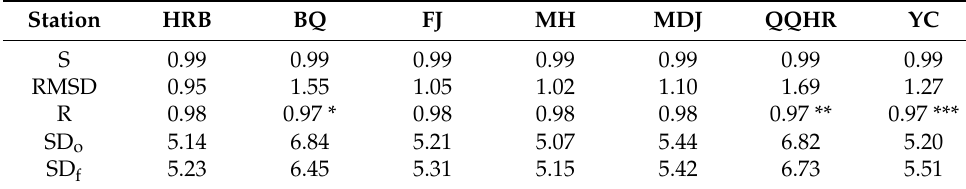
Figure 6. The Taylor diagram of CEEMDAN-LSTM at each station in Heilongjiang Province. Table 7. The S, RMSD, R, and SD of CEEMDAN-LSTM at each